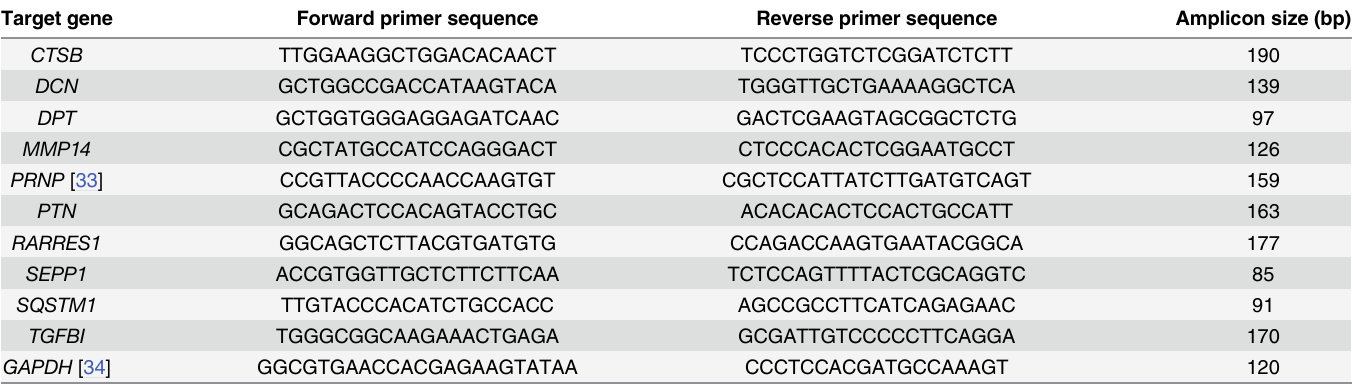
Table 1. Primers used for